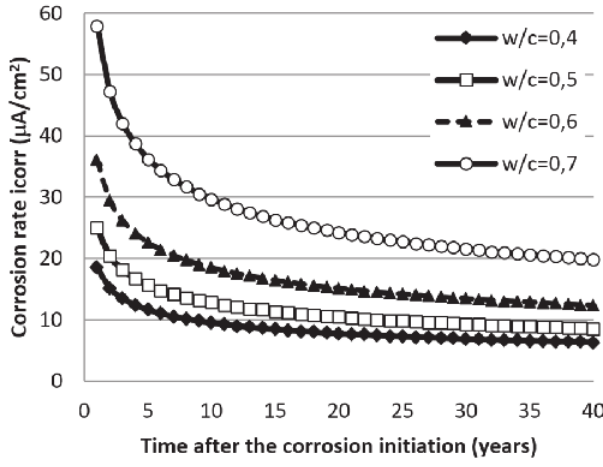
Evolution of the corrosion rate along time (t considering cover depth of 4